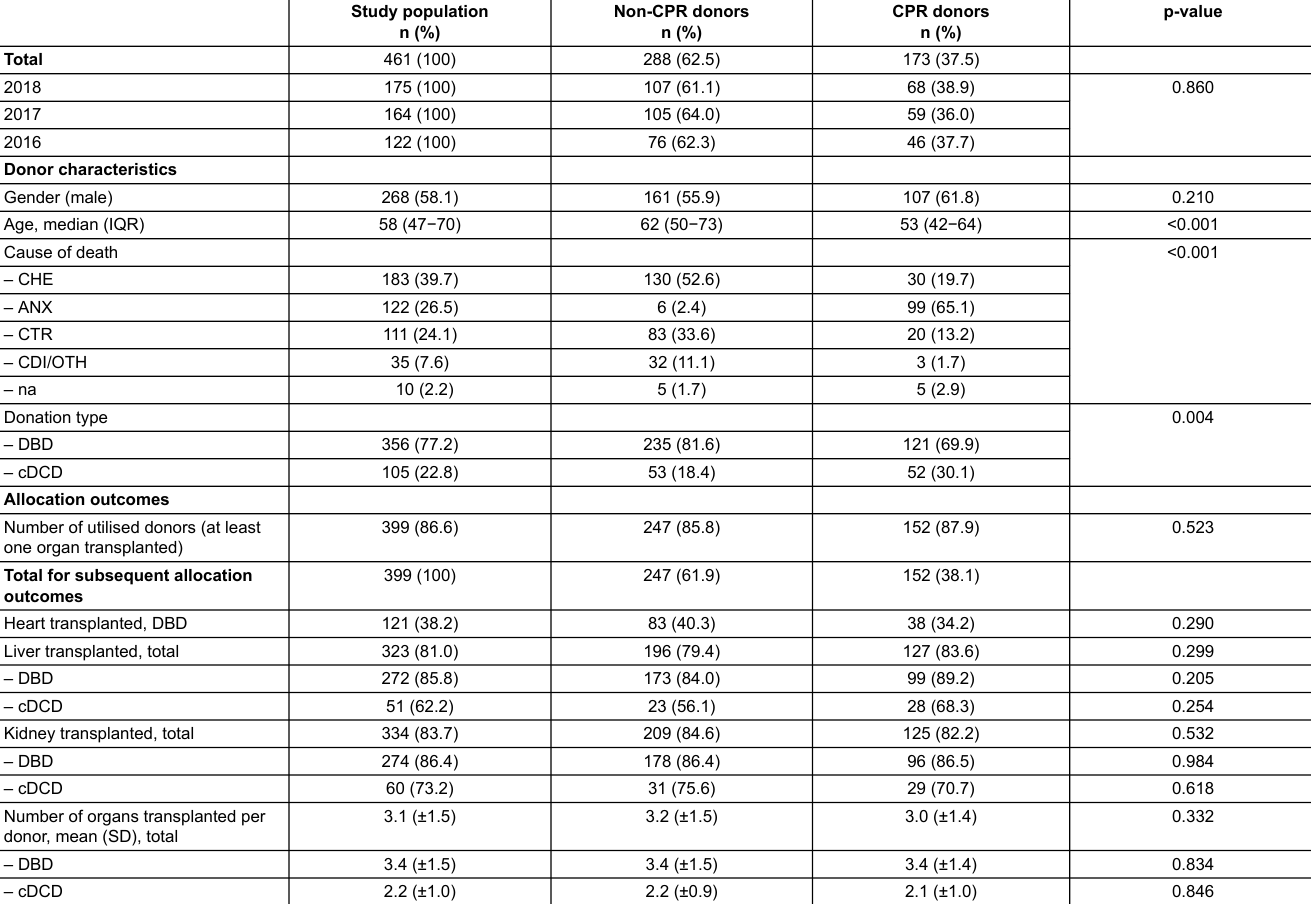
Table 1: Baseline characteristics and allocation outcomes of donors who underwent cardiopulmonary resuscitation (CPR) in context of their hospitalisation (CPR donors) as compared with donors without prior CPR in context of their hospitalisation (non-CPR donors).